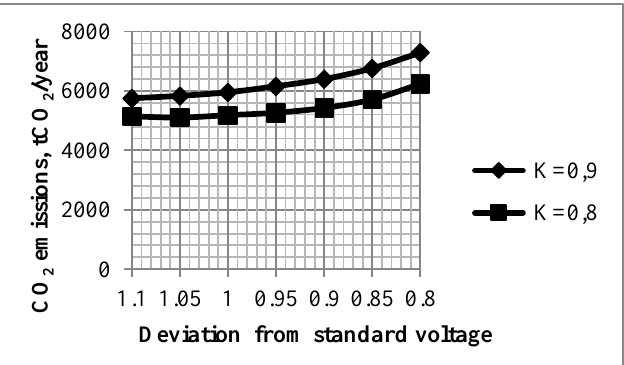
Fig. 4. Reduction of GHG emissions in Substation TP-26.